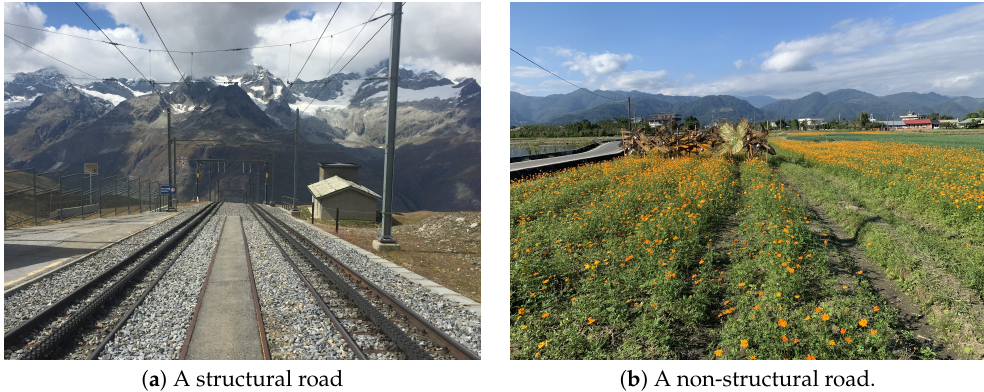
Figure 35. The limitation of finding the vanishing point when the input image is like ( b